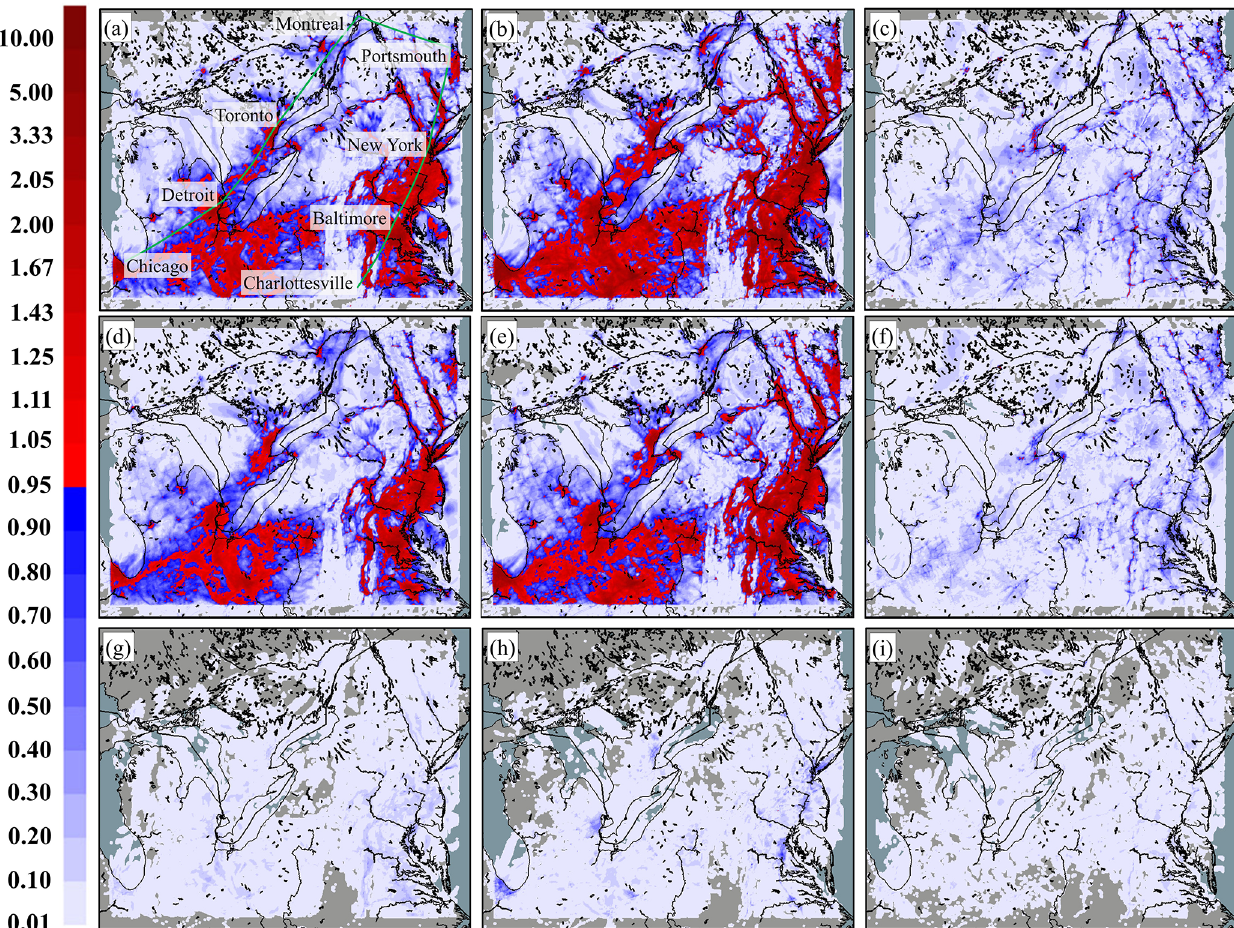
Figure 12. The 90% confidence ratio values (see Eq. 14) for the 30d average surface NO 2 , PM 2 . 5 , and O 3 , January 2016, in the Pan Am 2.5km grid cell size domain simulation. Panels arranged as in Fig. 10: (10:00, 14:00, and 22:00UTC) according to species: (a–c) NO 2 ; (d–f) PM 2 . 5 ; (g–i) O 3 (ppbv). Green line in (a) indicates the position of the vertical cross section shown in Fig. 13. Values > 1 . 0 (red colors) indicate that the simulations differ at greater than 90%